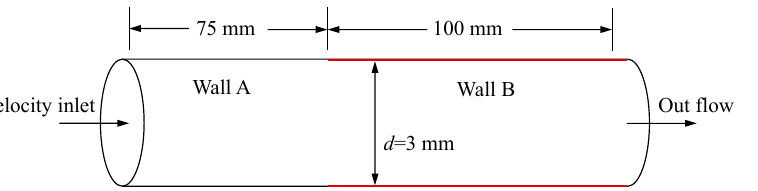
Figure 1. Illustration of the calculation domain of liquid hydrogen flow in horizontal pipe [30].